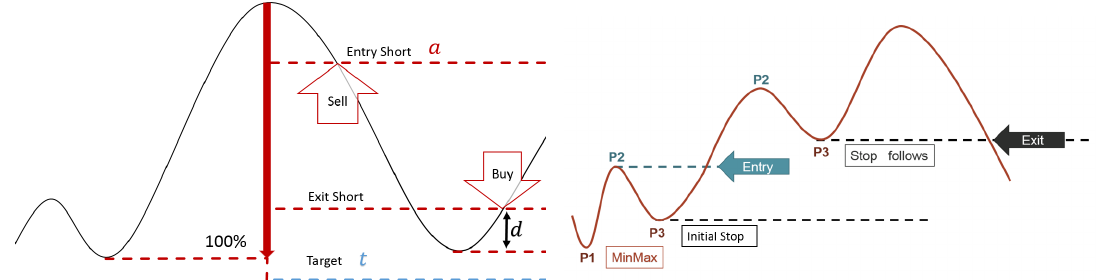
Figure 13. Setup of a basic anti- and pro-cyclic trading system for up-trends ( a and b ,